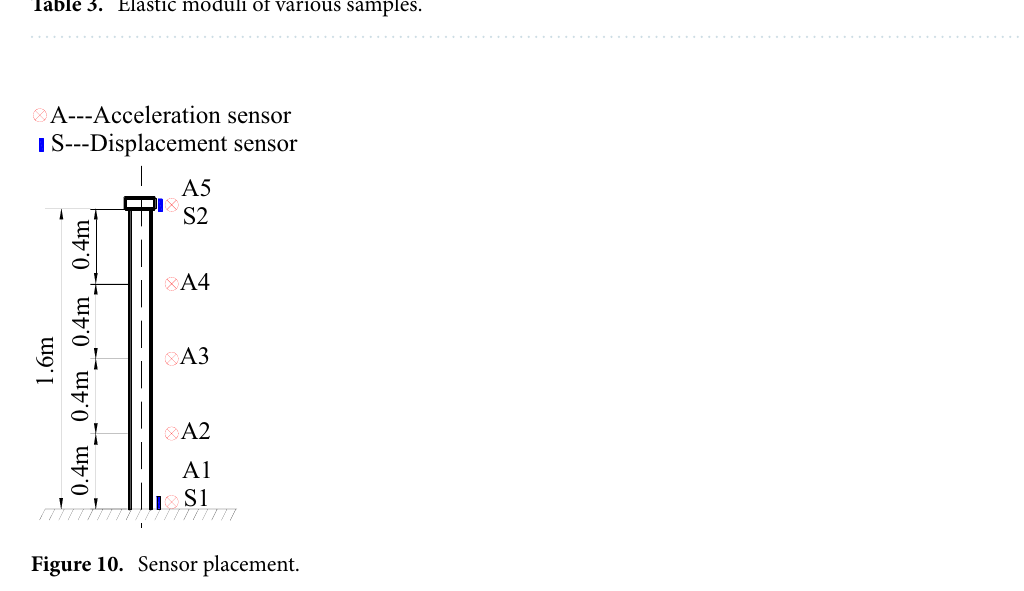
Table 3. Elastic moduli of various samples.